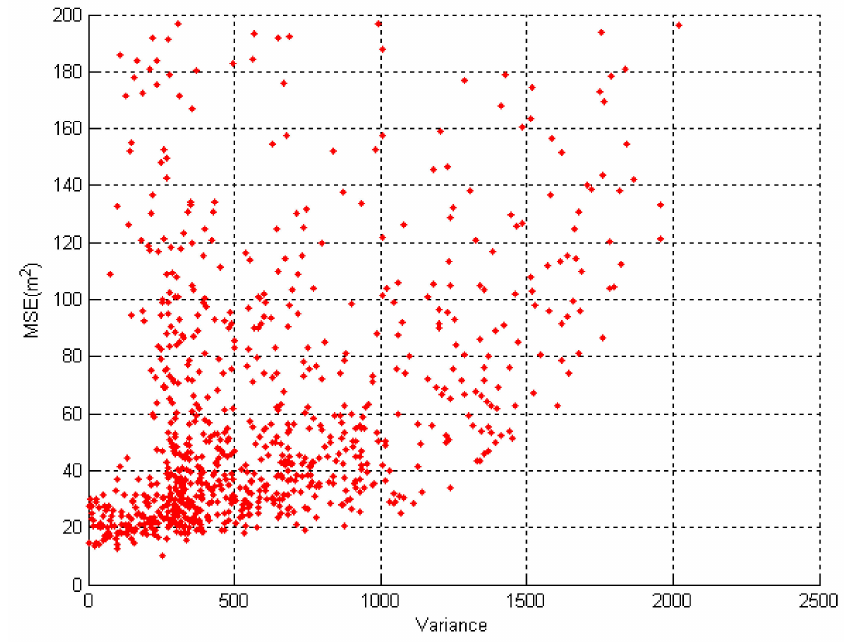
Figure 7. The relationship between the variation and MSE before conditions are